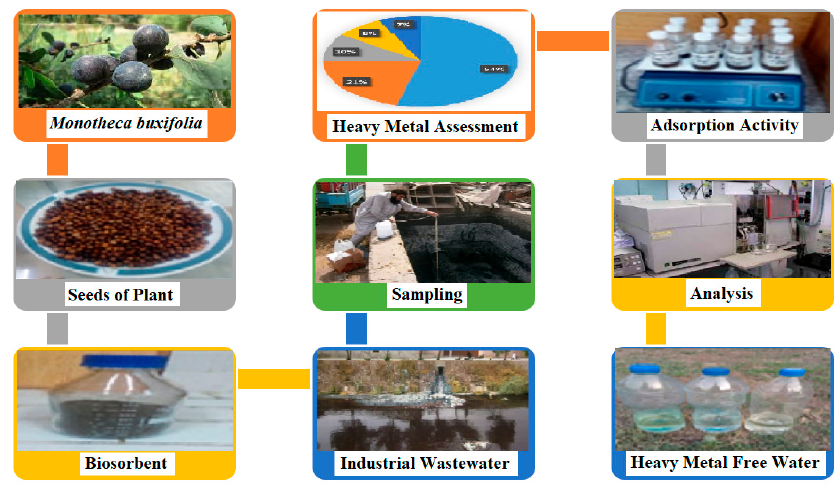
Scheme 1. Flow diagram of the research study